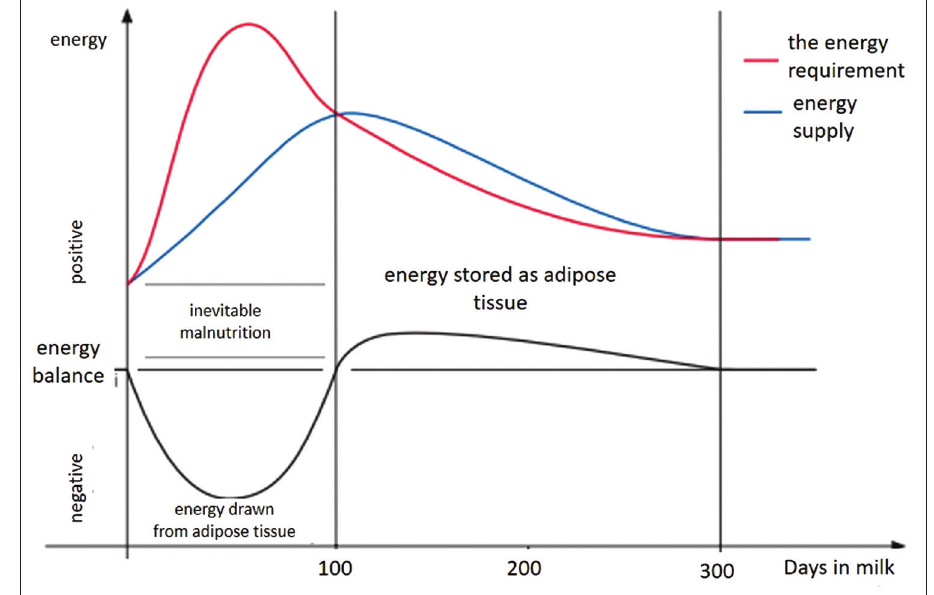
Figure 3: Dairy cows energy balance